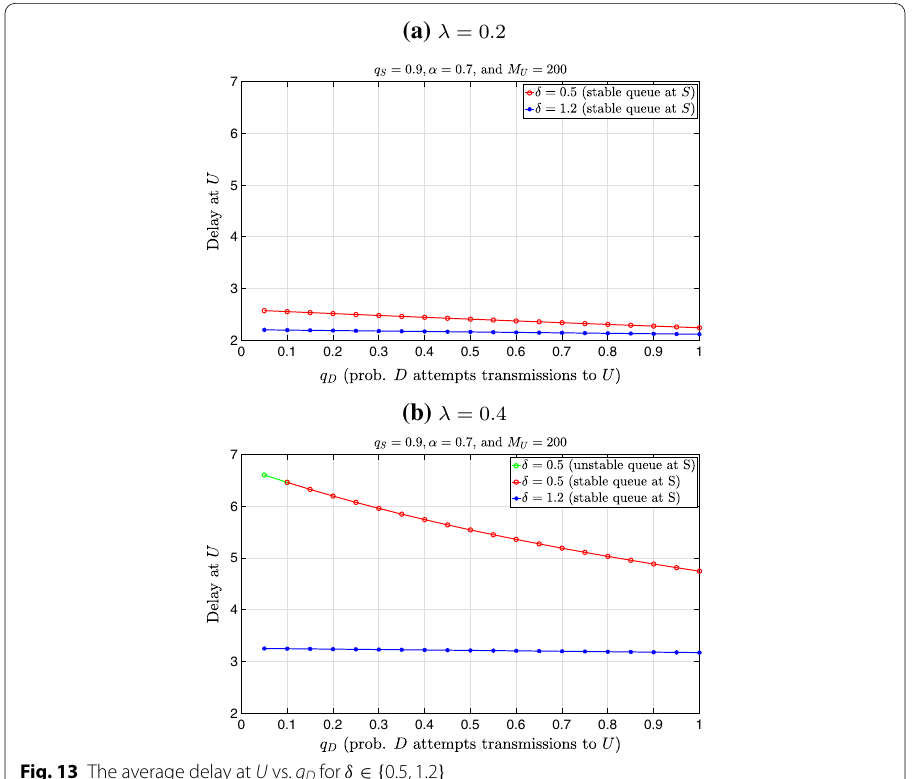
Fig. 13 The average delay at U vs. q D for δ ∈ { 0.5,1.2 }